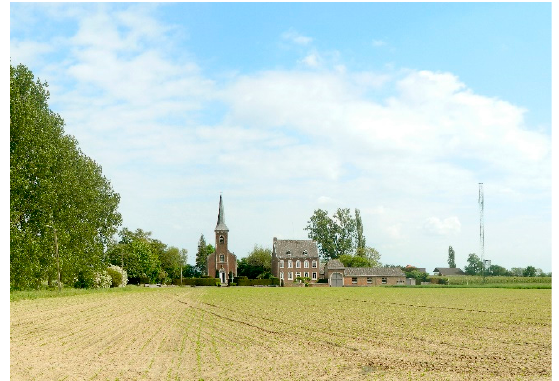
Figure 1. View of the St. Odulphus site with the ensemble of the church, the former rectory and the guild hall in the rural environment of Hageland Belgium.